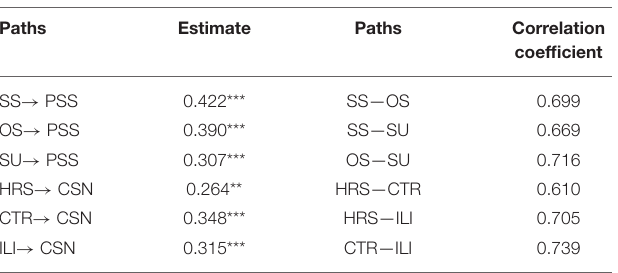
TABLE 3 | High order factor analysis.